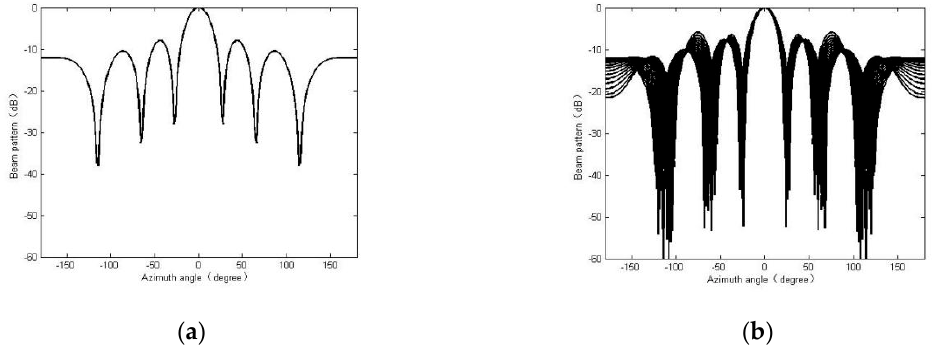
Figure 3. Experimental comparison of focusing frequency at 2450 Hz. ( a ) Narrowband beam pattern at 2450 Hz; ( b ) broadband beam pattern focused on the focusing frequency of 2450 Hz.